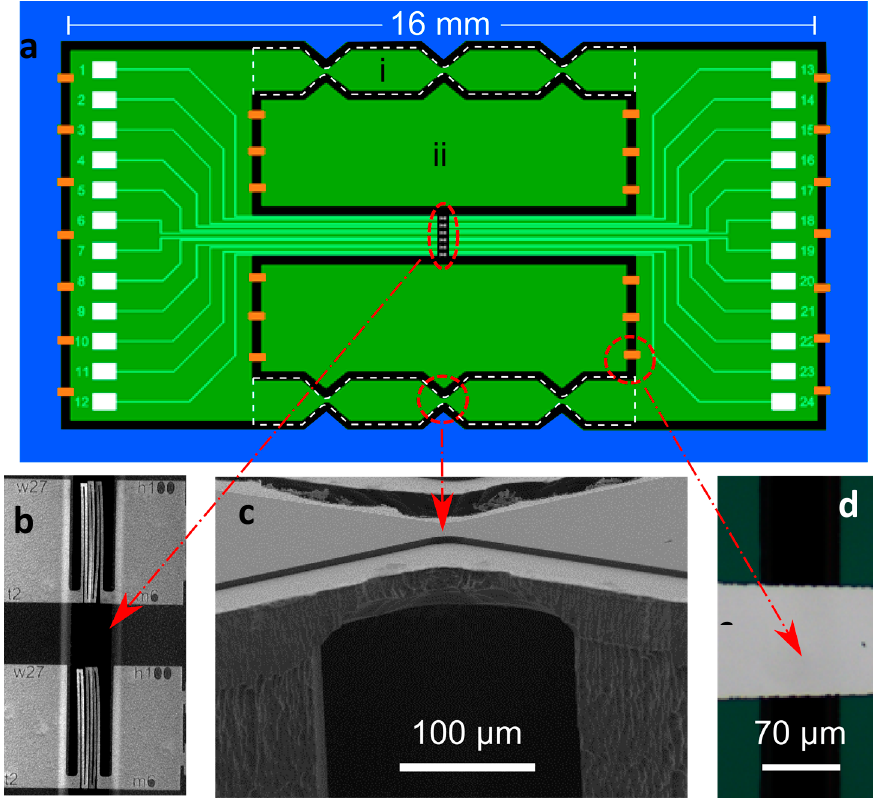
Figure A1. Design and details of the fabricated test chip with highly stretchable interconnects. ( a ) The design of the (16 mm × 5 mm) chip (in green), which is suspended in the silicon wafer (in blue) by polyimide tabs (in orange). Notched silicon columns ( i ) are processed to provide rigidity to the structure during processing and handling. Sacrificial silicon islands ( ii ) are created and suspended by similar polyimide tabs to reduce etching time; ( b ) Magnified view of two parallel free-standing interconnects; in total there are six parallel interconnect structures, processed in each test chip; ( c ) Magnified side-view of a (200 μ m wide, 100 μ m thick, double V-notched) silicon bridge inside the bottom ‘column’ of the test chip; ( d ) Magnified top-view of a polyimide tab, which can easily be locally melted to singulate the test chip.